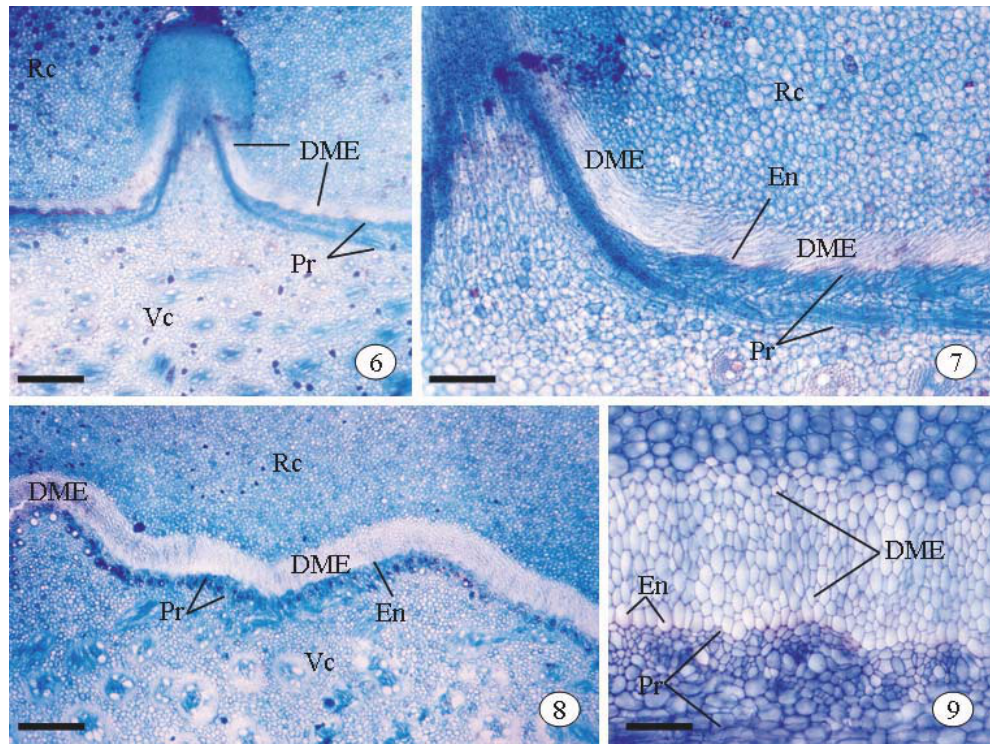
Fig. 6-9 – Cyperus papyrus . Transverse sections of the rhizome. Note (Fig. 6, 7 and 8) continuity of tissues between the root and the rhizome; the endodermis (En) in Fig. 7 appears with Casparian strips (arrow). The pericycle (Pr) appears as generating tissue of vascular tissues, especially in Fig. 9. DME – Derivatives of the Meristematic Endodermis; Rc – rhizome cortex;Vc – vascular cylinder. The bars correspond respectively to: 600 µ m, 400 µ m, 400 µ m and 100 µ